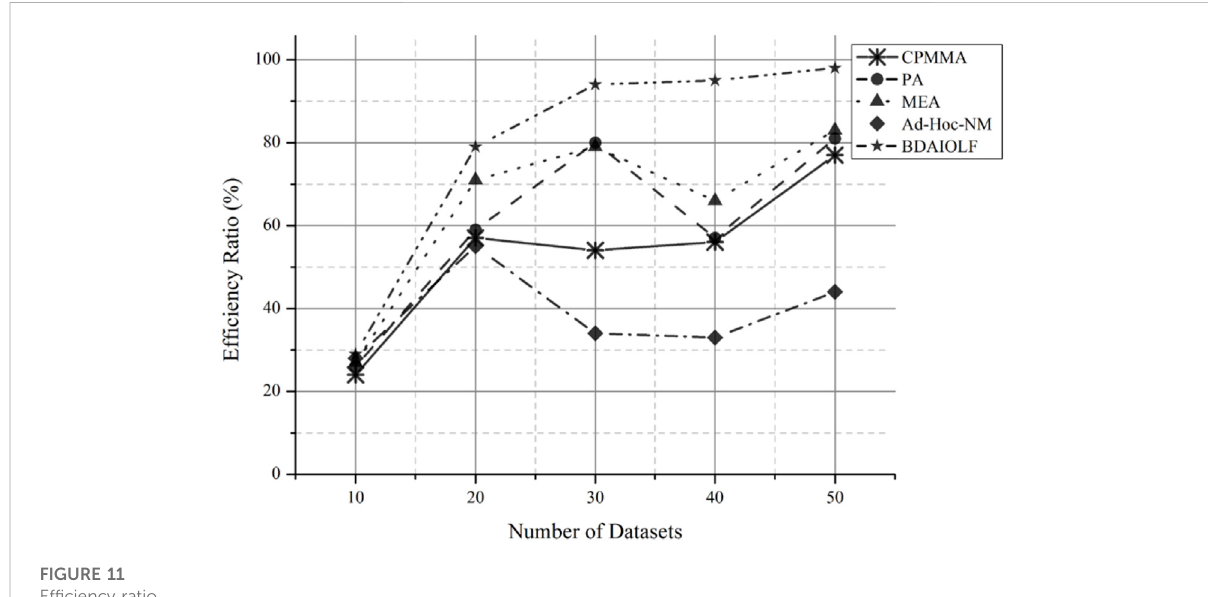
FIGURE 11 Ef fi ciency